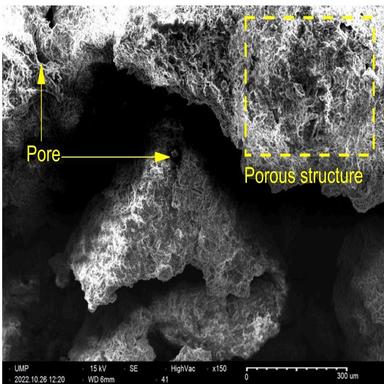
SEM micrograph of raw OP.